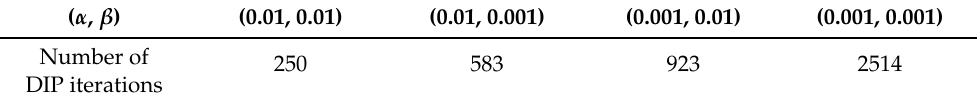
Table 9. Average number of DIP iterations taken for reconstruction for different α and β .